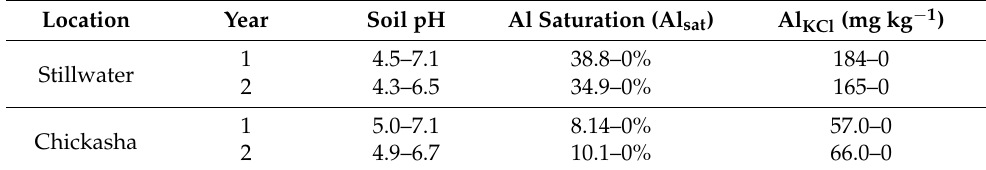
Table 1. Soil pH, aluminum saturation (Al sat ), and exchangeable aluminum (Al KCl ) range for Stillwater and Chickasha during Year 1 and Year